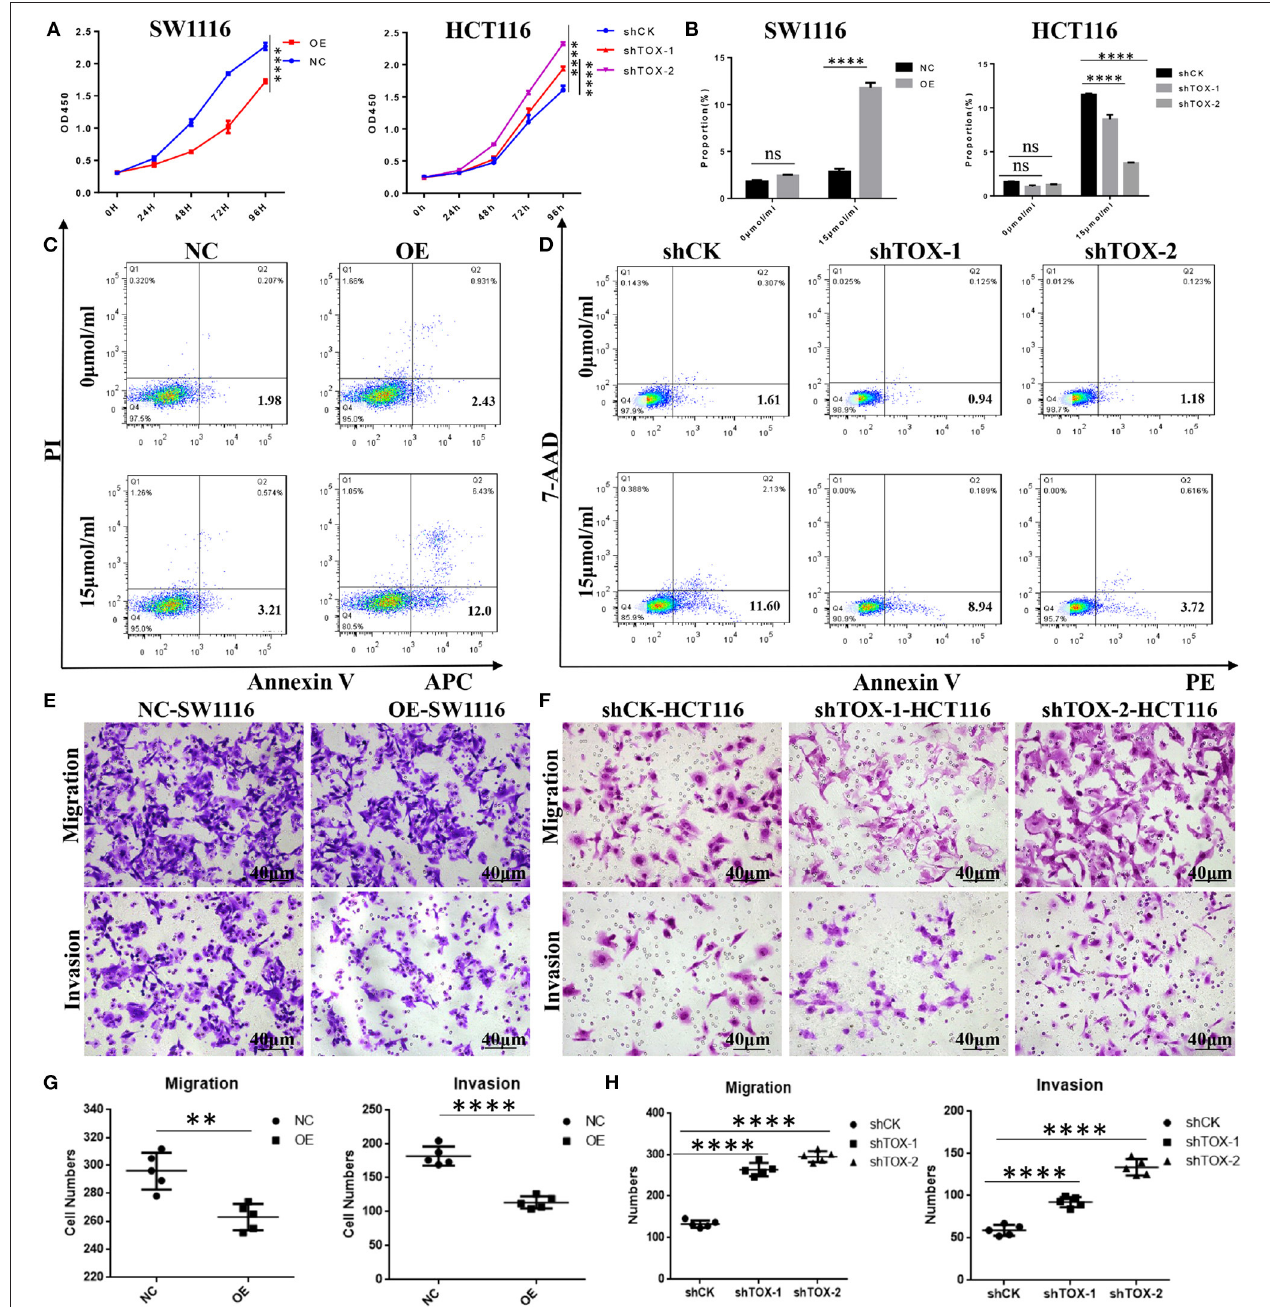
FIGURE 3 | TOX expression suppresses cancer cell proliferation, migration, invasion, and promotes apoptosis in vitro . (A) Cell proliferation was detected by CCK8 in SW1116 (MSS) and HCT116 (MSI) cells. (B) The statistical results of the apoptosis experiment. (C) FACS analysis of apoptosis assay in PLVX-Flag and PLVX-Flag-TOX SW1116 cells. (D) FACS analysis of apoptosis assay in shCK HCT116 and shTOX HCT116 cells. (E,G) Transwell assays show migration and invasion of PLVX-Flag and PLVX-Flag-TOX SW1116 cells. (F,H) Transwell assays show migration and invasion in shCK and shTOX HCT116 cells. Each experiment was repeated three times. ** p < 0.01, **** p < 0.0001.